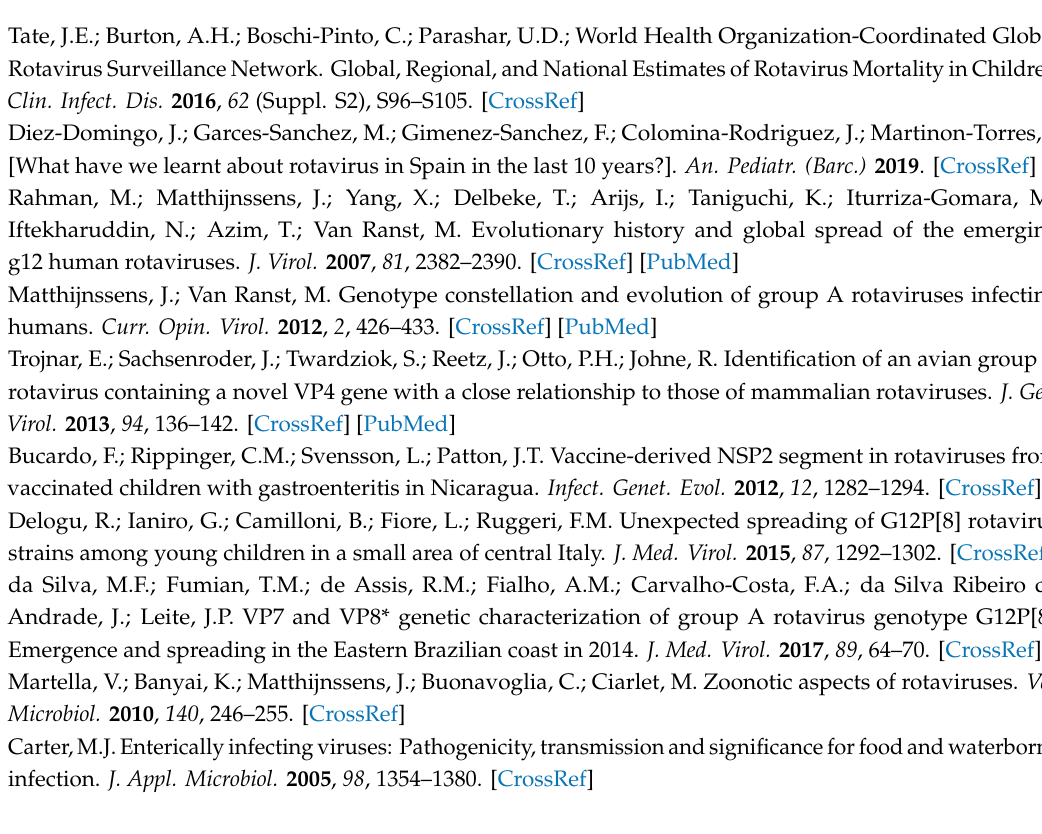
Table S1: Data on mean RVA load detected from fecal samples recovered from